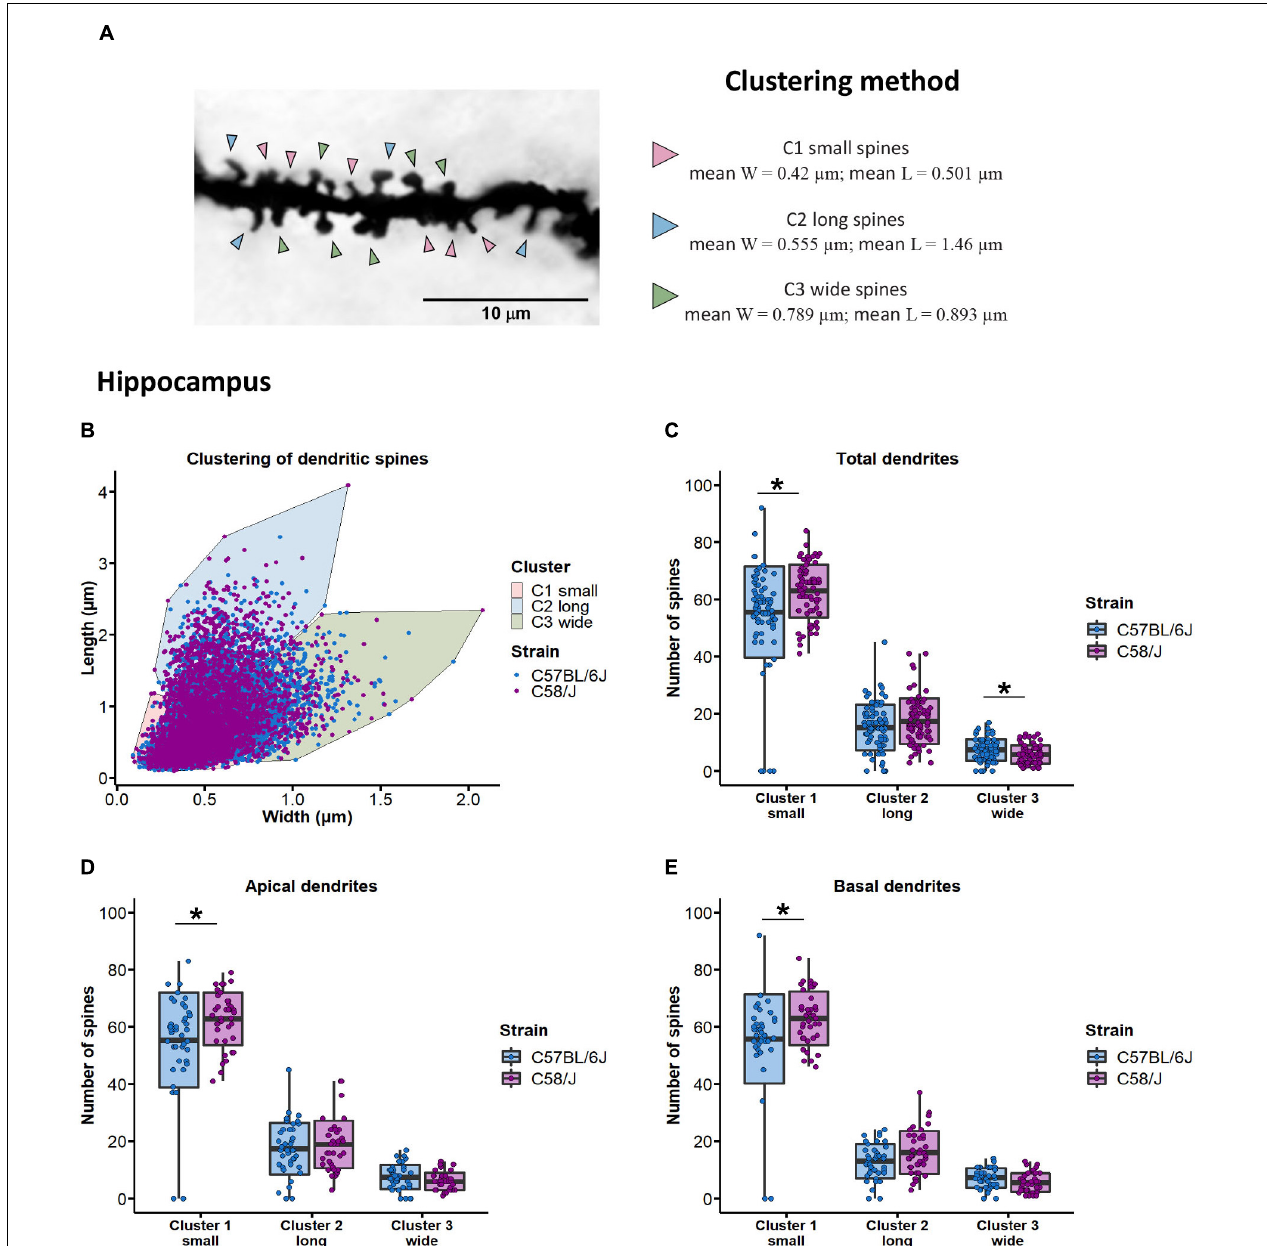
FIGURE 5 | Clustering of dendritic spines by length and width dimensions in the hippocampus of C58/J mice. Dendritic spines are grouped in three clusters (A) . Arrowheads are pointing to examples of small , long , and wide spines. Distribution of dendritic spines in three main clusters using the K-means algorithm (B) . Clusters were defined as small , long , and wide spines, according to their length and width parameters. Number of dendritic spines grouped in each cluster, in total (C) , apical (D) , and basal (E) dendrites of pyramidal neurons in the hippocampus of C57 BL/6J (neurotypical phenotype) and C58/J (autistic-like phenotype) mice. Results are expressed as mean ± SD; n = 20 neurons per strain, five neurons per mouse. t -test with Holm–Bonferroni correction: * p < 0.05.